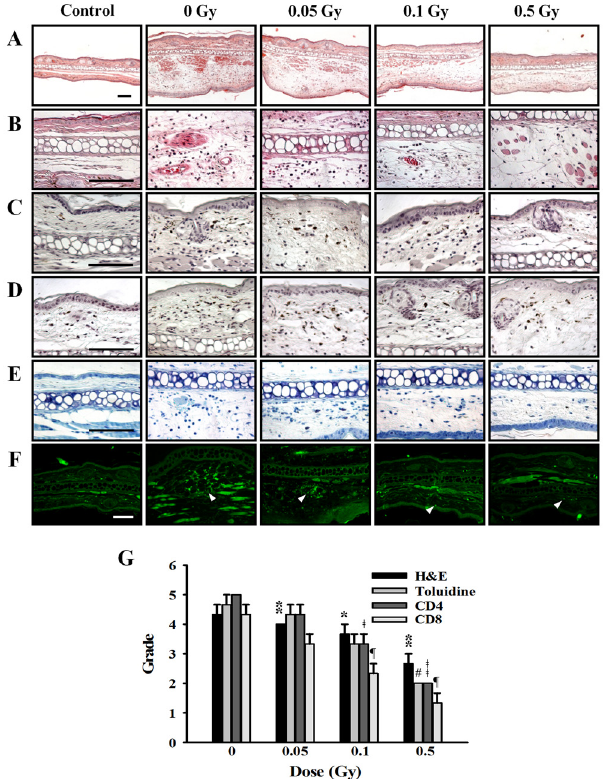
Fig 9. Effects of ionizing radiation on histological changes in ear tissues of late-phase cutaneous reaction model. (A) Mice were passively sensitized by i.v. injection of 2 μ g anti-DNP IgE. After 24 h, mice were irradiated with 0 – 0.5 Gy before 2 μ l of 0.3% DNFB in acetone/olive oil (4:1) was applied epicutaneously to the sides of the left ear. Acetone/olive oil (20 μ l) was applied to the right ear as a control. After 24 h, sections of ear tissue were stained with H&E (A and B), immunohistochemistry for CD4 (C) and CD8 (D), toluidine blue (E), and Fc ε RI expression (F) observed at 100× or 400× magnification. Histological appearance was score for the presence of infiltrating cells (G). Bars = 100 μ m. * p < 0.05, # p < 0.05, ǂ p < 0.05, ¶ p < 0.05 versus the corresponding 0 Gy of H&E, Toluidine, CD4, and CD8,